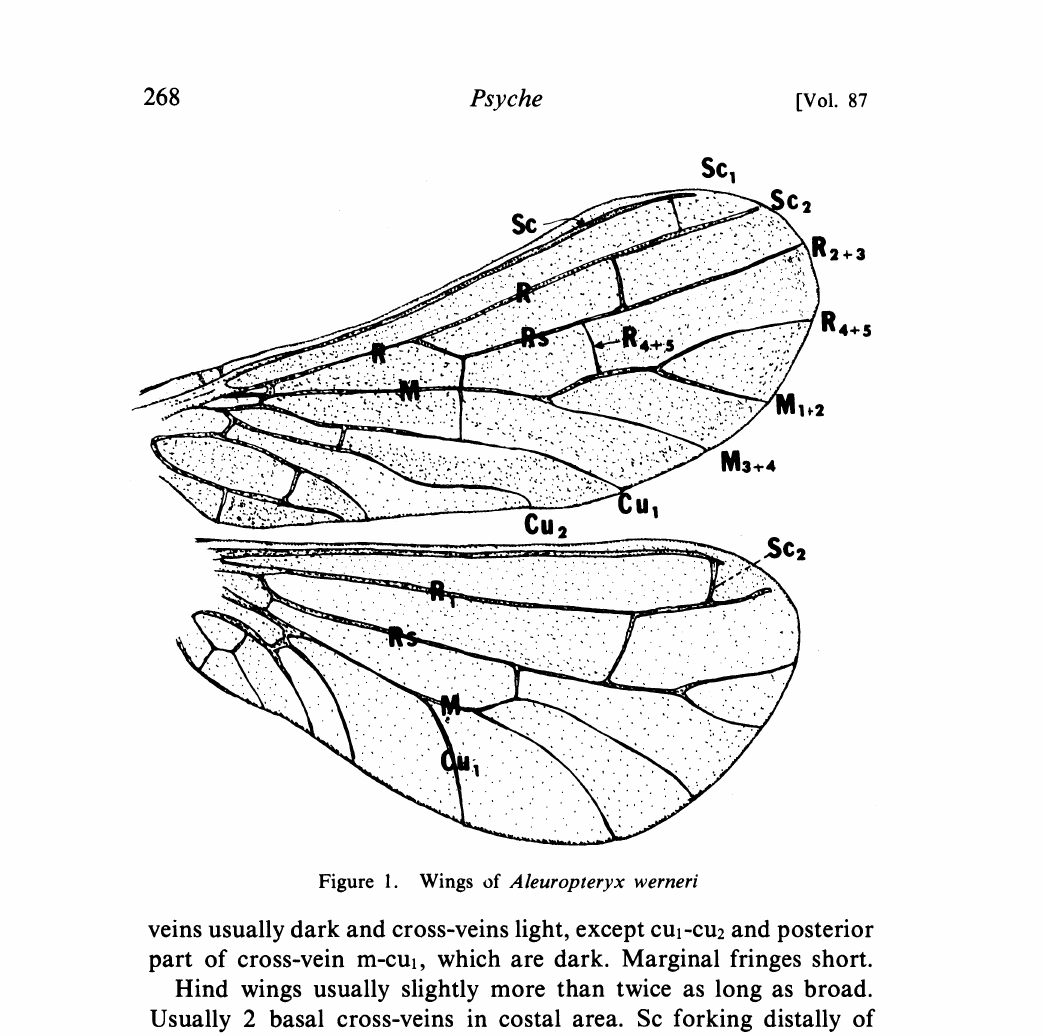
Figure 1, Wings of Aleuropteryx